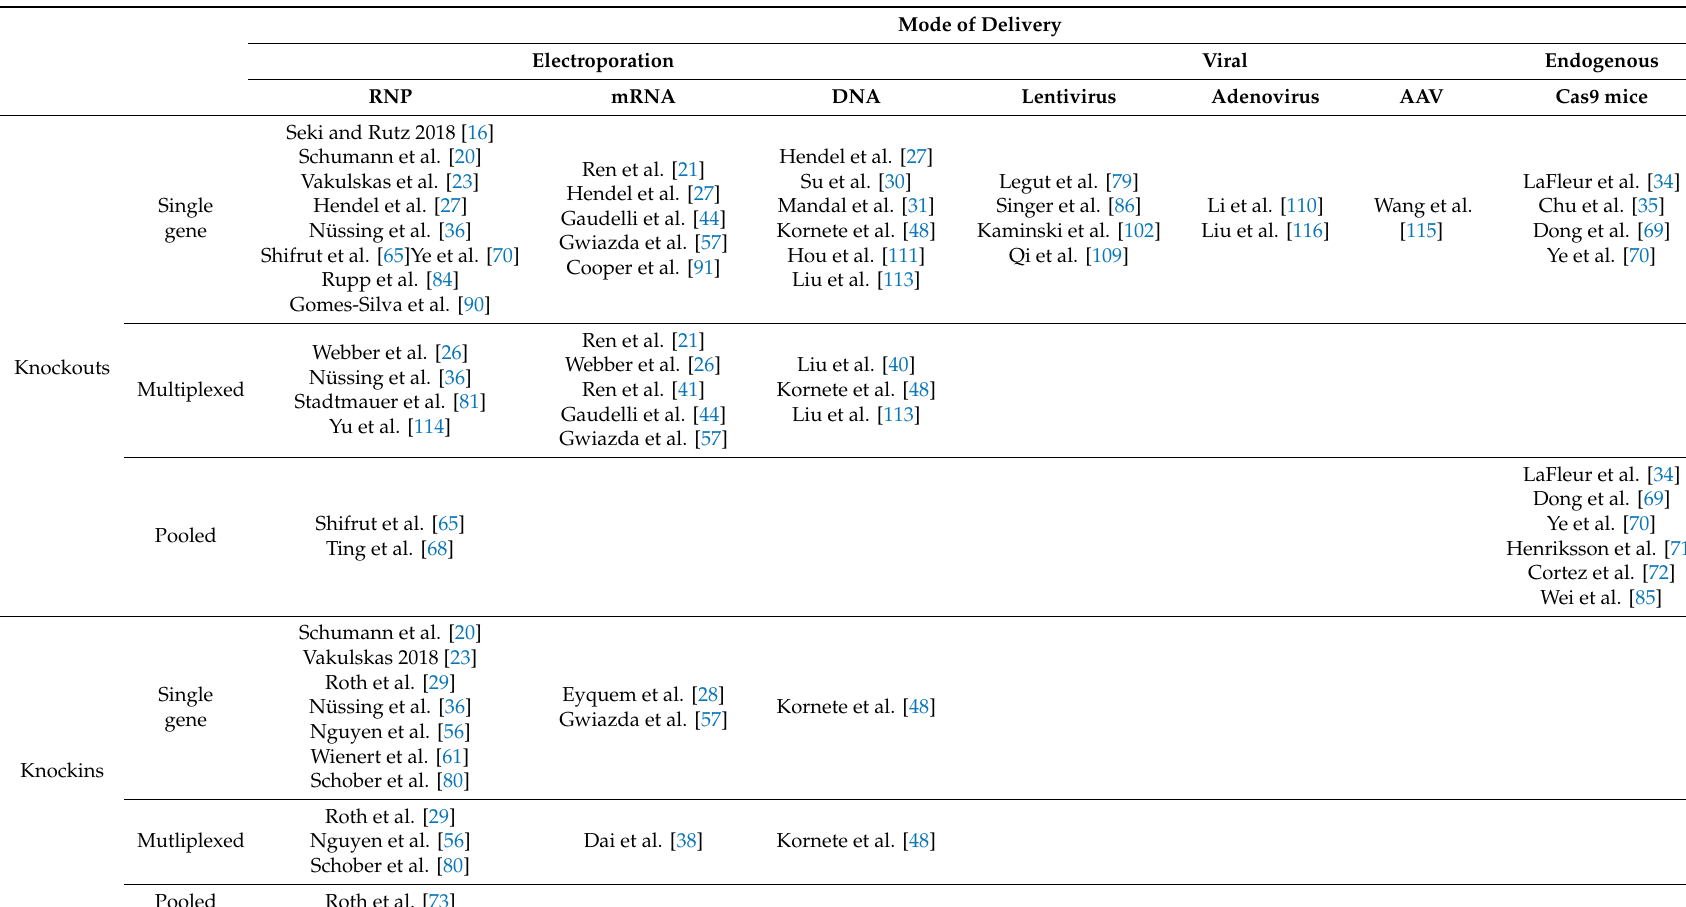
Table 1. Summary of all the edit types performed in primary T cells and methods used to deliver Cas